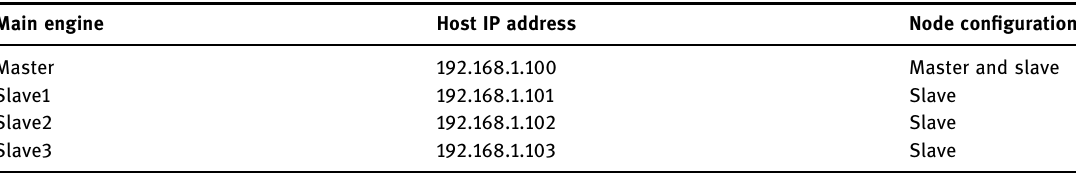
Table 2: IP con fi guration and node con fi guration of operation platform Main